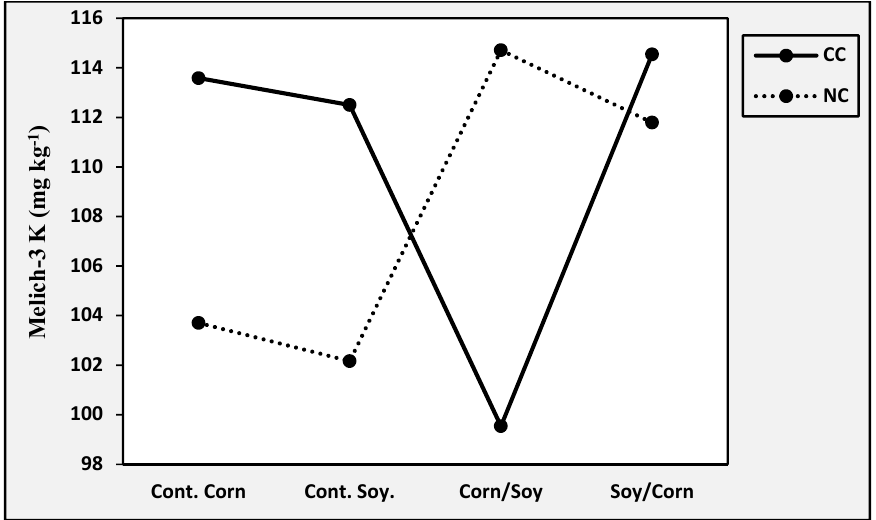
Figure 3. Effects of crop rotation x cover crop interaction on Melich-3 K in 2013. Please note that CC = cover crop; NC = no cover crop.